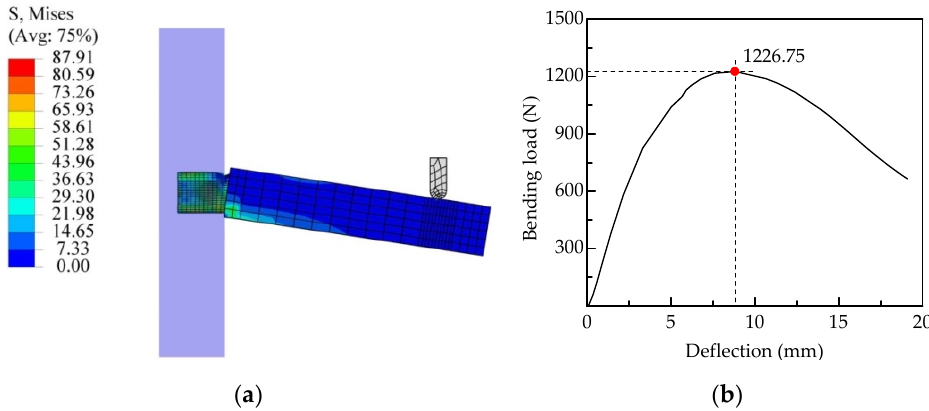
Figure 7. Results of the finite element model with optimized tenon size, ( a ) stress distributions (unit MPa), and ( b ) bending load-deflection curve of M–T joints with maximum bending load values.